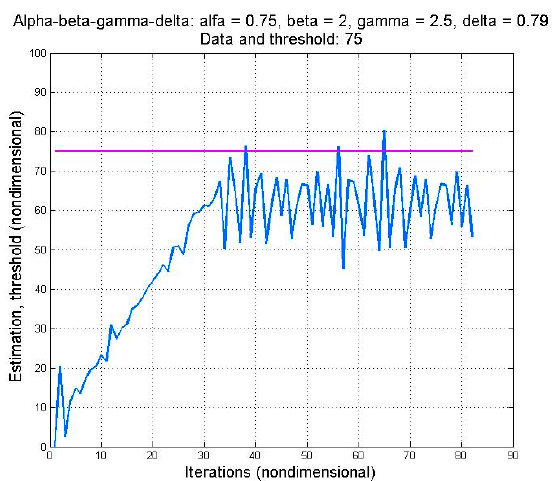
Figure 19. With the second set of parameters, the α – β – γ filter provides estimates that exceed the threshold of 75.